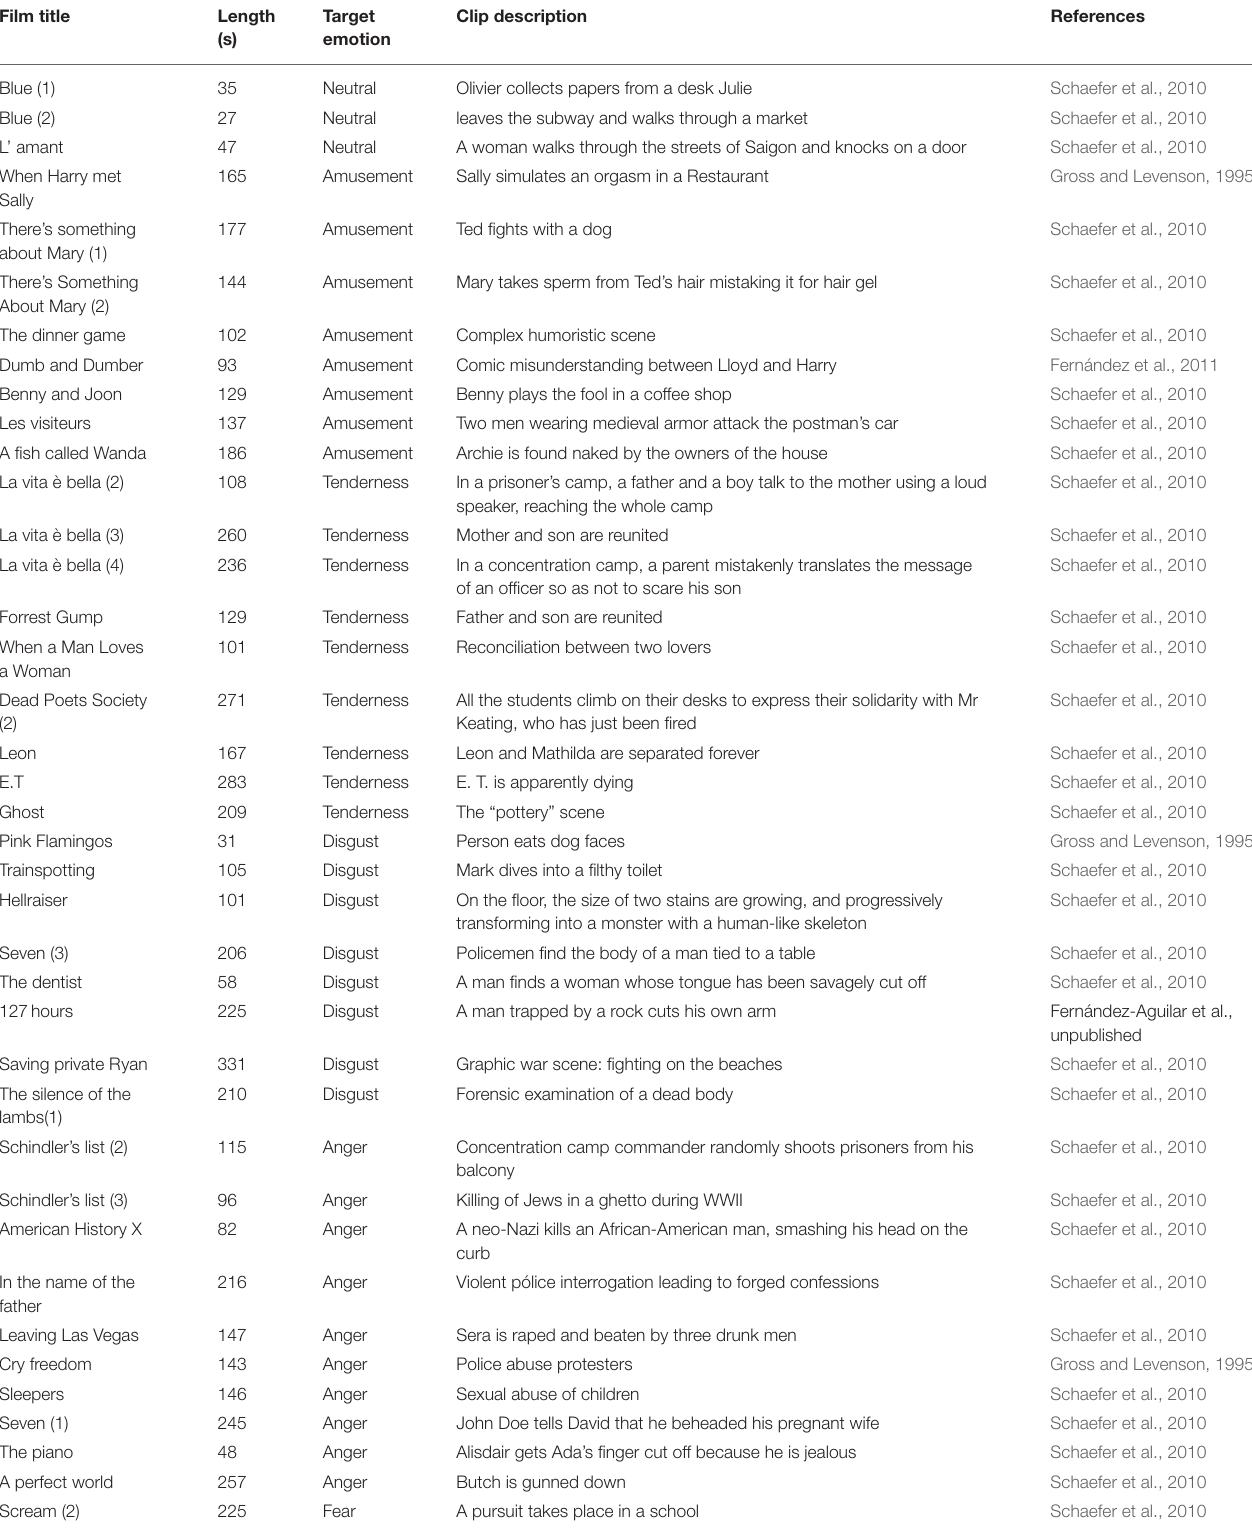
TABLE 1 | Description of the film